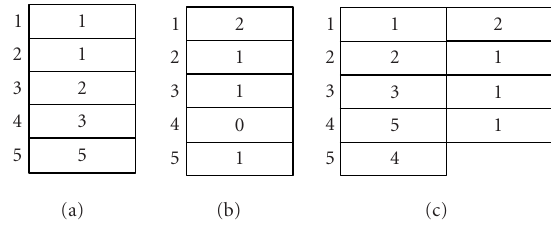
Figure 2: Types of memory usages: (a) indexes are positions of the replicated particles, (b) indexes are replication factors, and (c) in- dexes are arranged as positions and replication